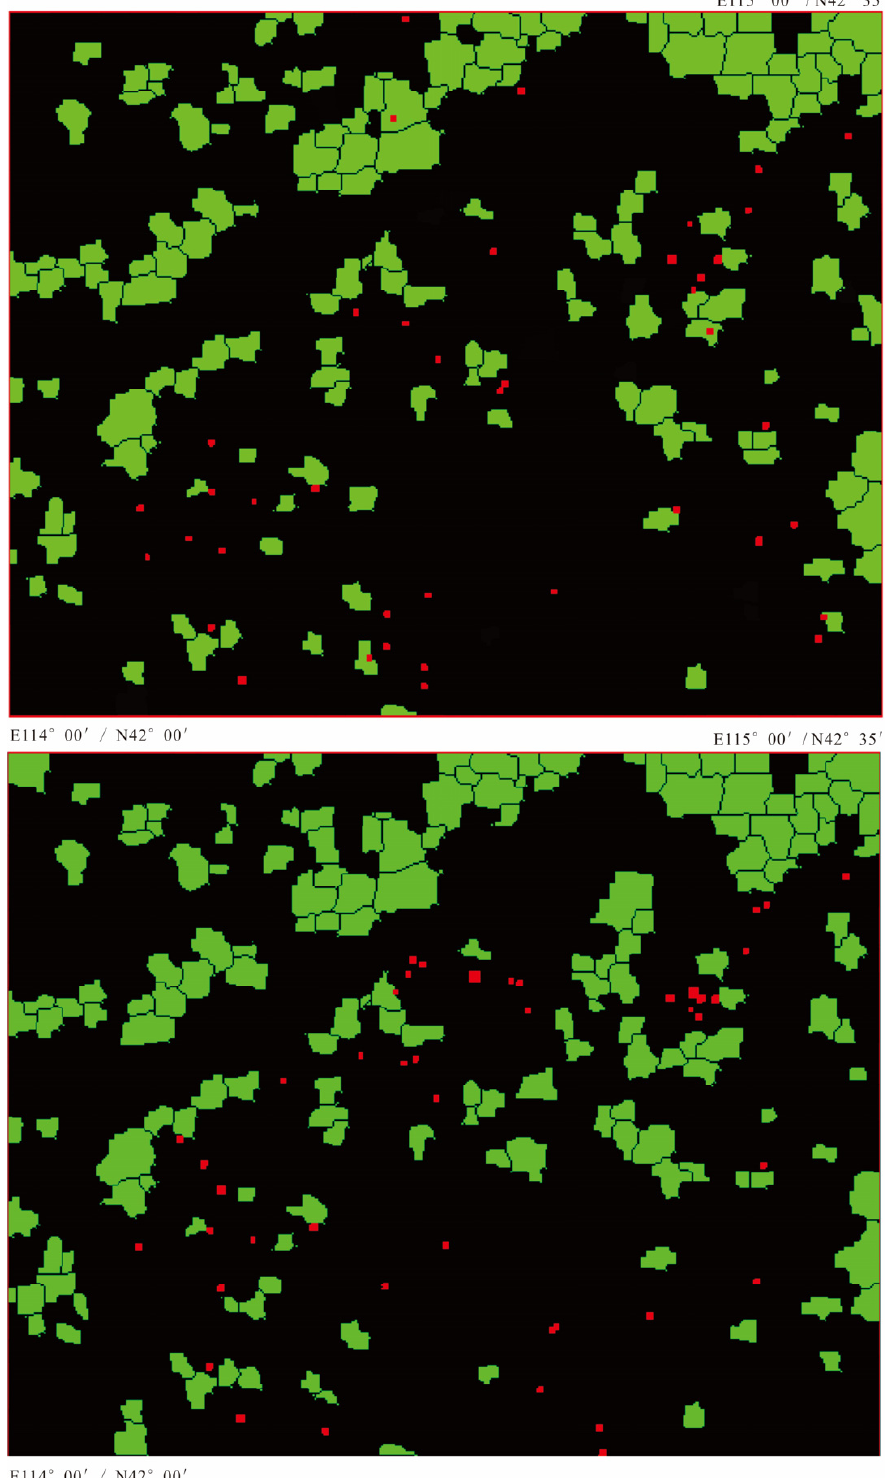
Figure 12. (upper) the object-based D 2 map for I-series elements with relevant ore spots (red squares) overlaid on it. (lower) the D 2 map for S-series elements with relevant ore spots overlaid on it. The green colored patches represent the delineated non-anomalous regions.